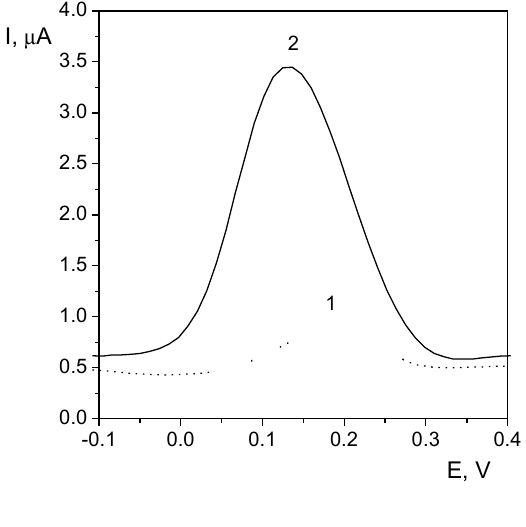
Figure 2. DP voltammograms of 5 × 10 -7 mol/l [Co(phen) DNA/CPE (2) after 120 s accumulation of the indicator at open circuit and room temperature. Other conditions as in Figure